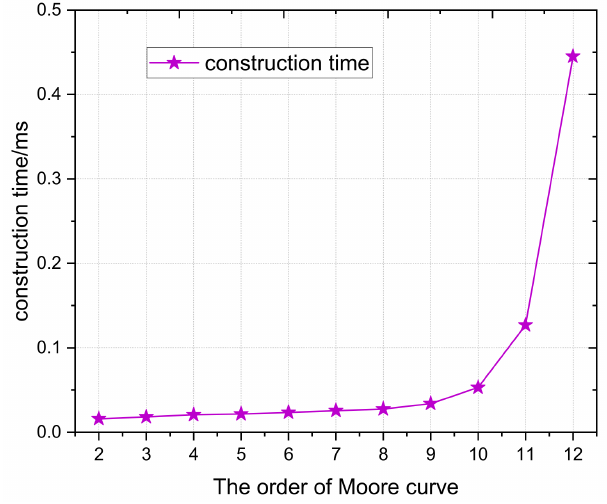
Figure 6. Time cost for constructing Moore